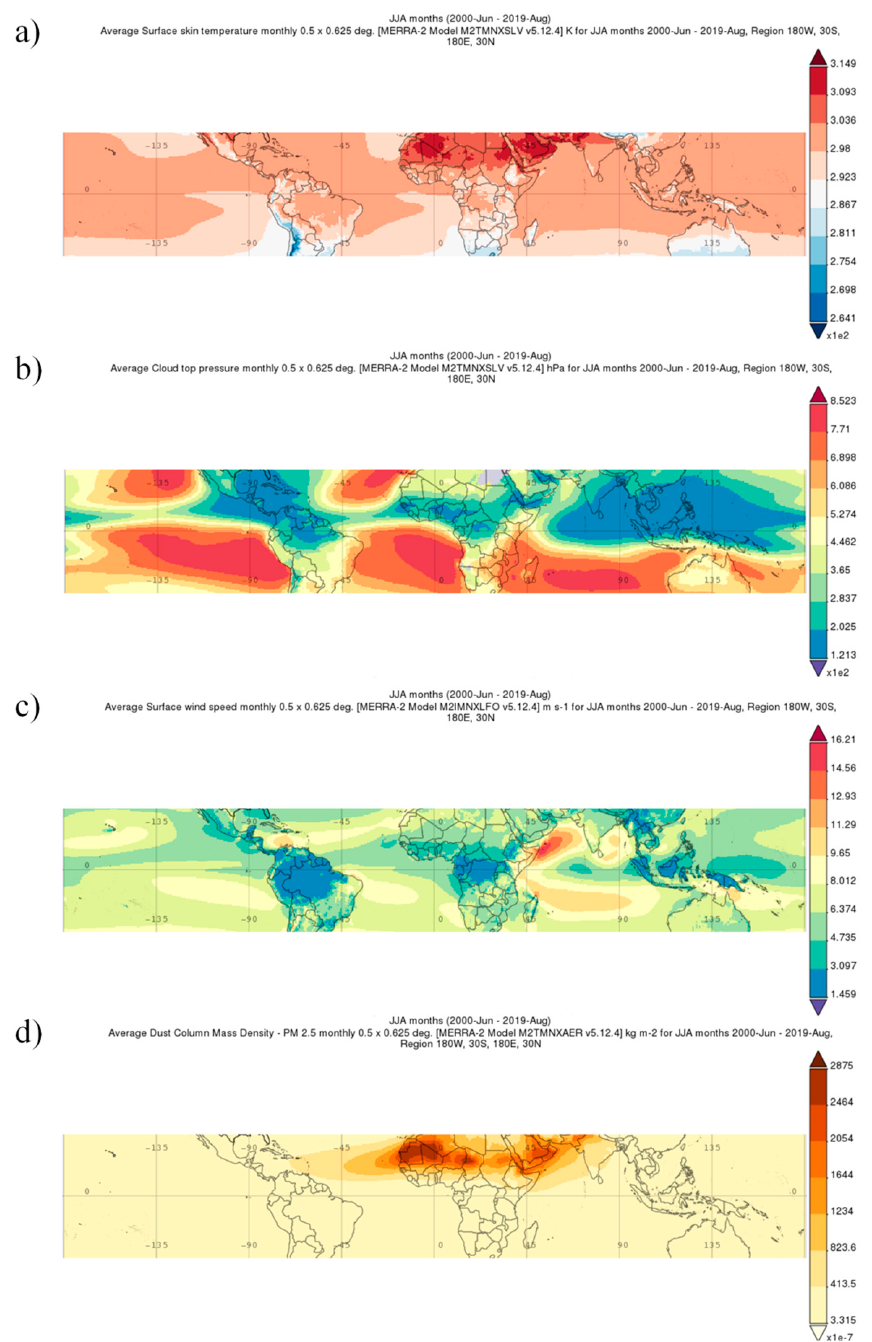
Figure 6. Similar to Figure 5 for June, July and August except from MERRA-2: ( a ) surface skin temperature (in Kelvin); ( b ) cloud top pressure (in hPa); ( c ) surface wind speed (in m/s); and ( d ) dust column mass density (in kg/m − 2 ).